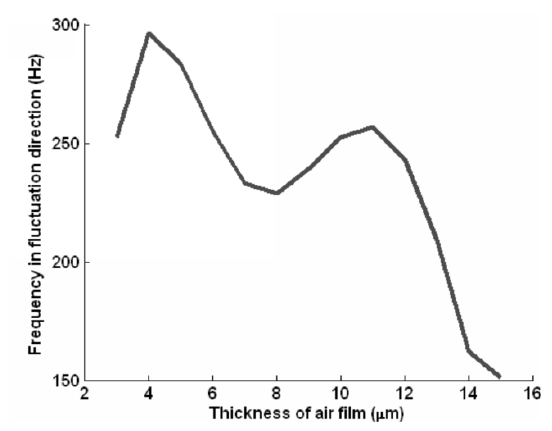
Figure 3. Frequency of the motion